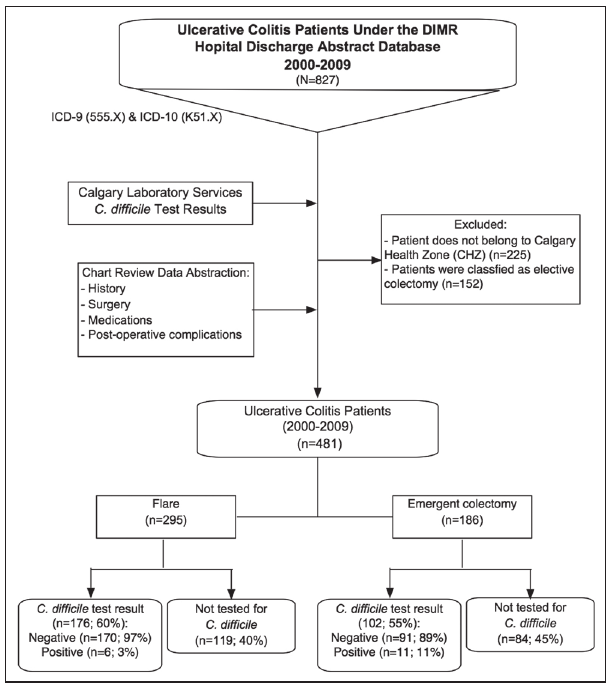
Figure 1) Flow diagram illustrating the inclusion and exclusion criteria for identifying patients admitted with a flare for ulcerative colitis and tested Clostridium difficile (C. difficile) infection in hospital and up to 90 days before admission. DIMR Data Integration, Measurement and